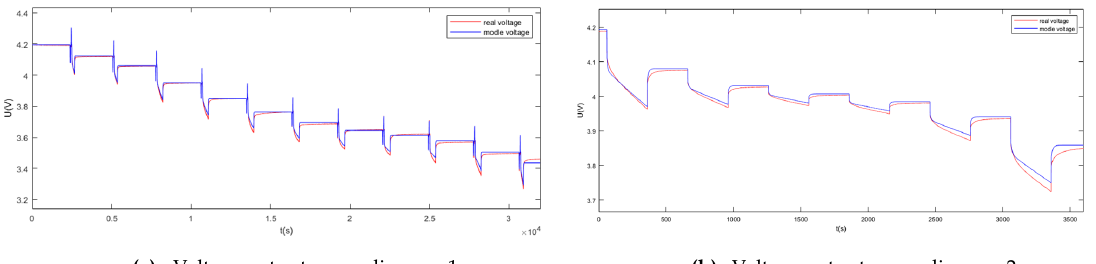
Figure 10. Voltage output curve diagram.